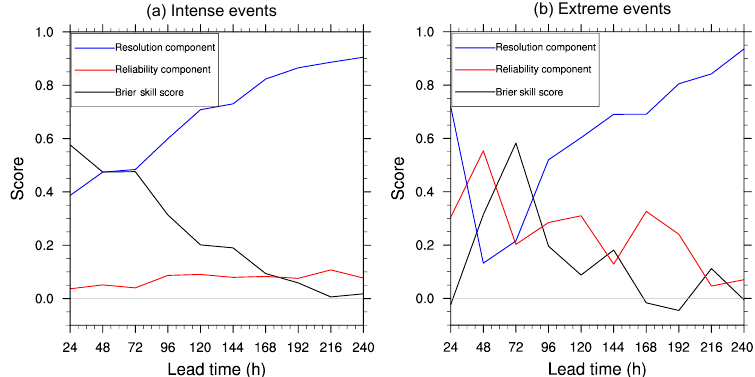
Figure 8. Brier skill score as a function of lead time for the SSI exceeding the 95th (a) and 99th percentiles of the model climatology (b) . The Brier skill score is decomposed into resolution and reliability components (see Eq. 1).